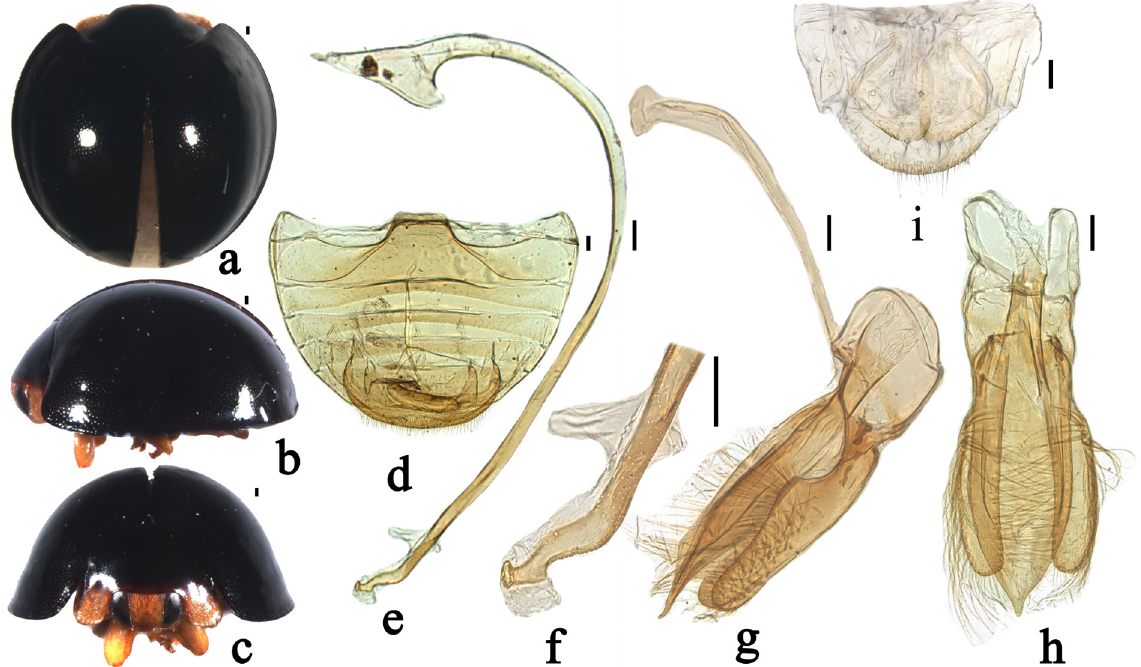
Fig. 4. Chilocorus nigrita (Fabricius, 1798). a . Dorsal view. b . Lateral view. c . Frontal view. d .